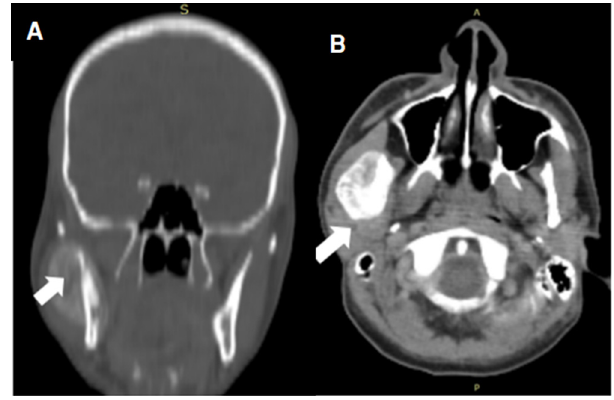
Fig. 4. (A and B) Axial and coronal sections of the post-chemotherapy CT scan showing ossi fi cation and reduction in the size of the lesion (indicated with